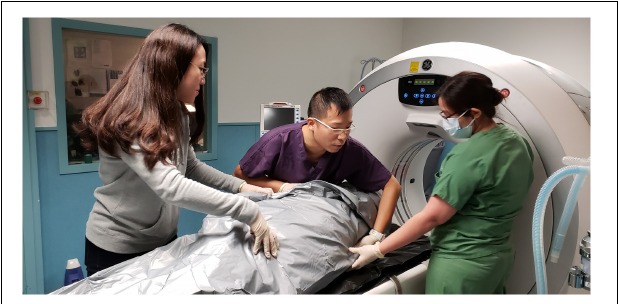
FIGURE 1 | Proper positioning of the carcass in the cadaver bag prior to the PMCT scan is essential, by palpating the flippers and other body landmarks of the